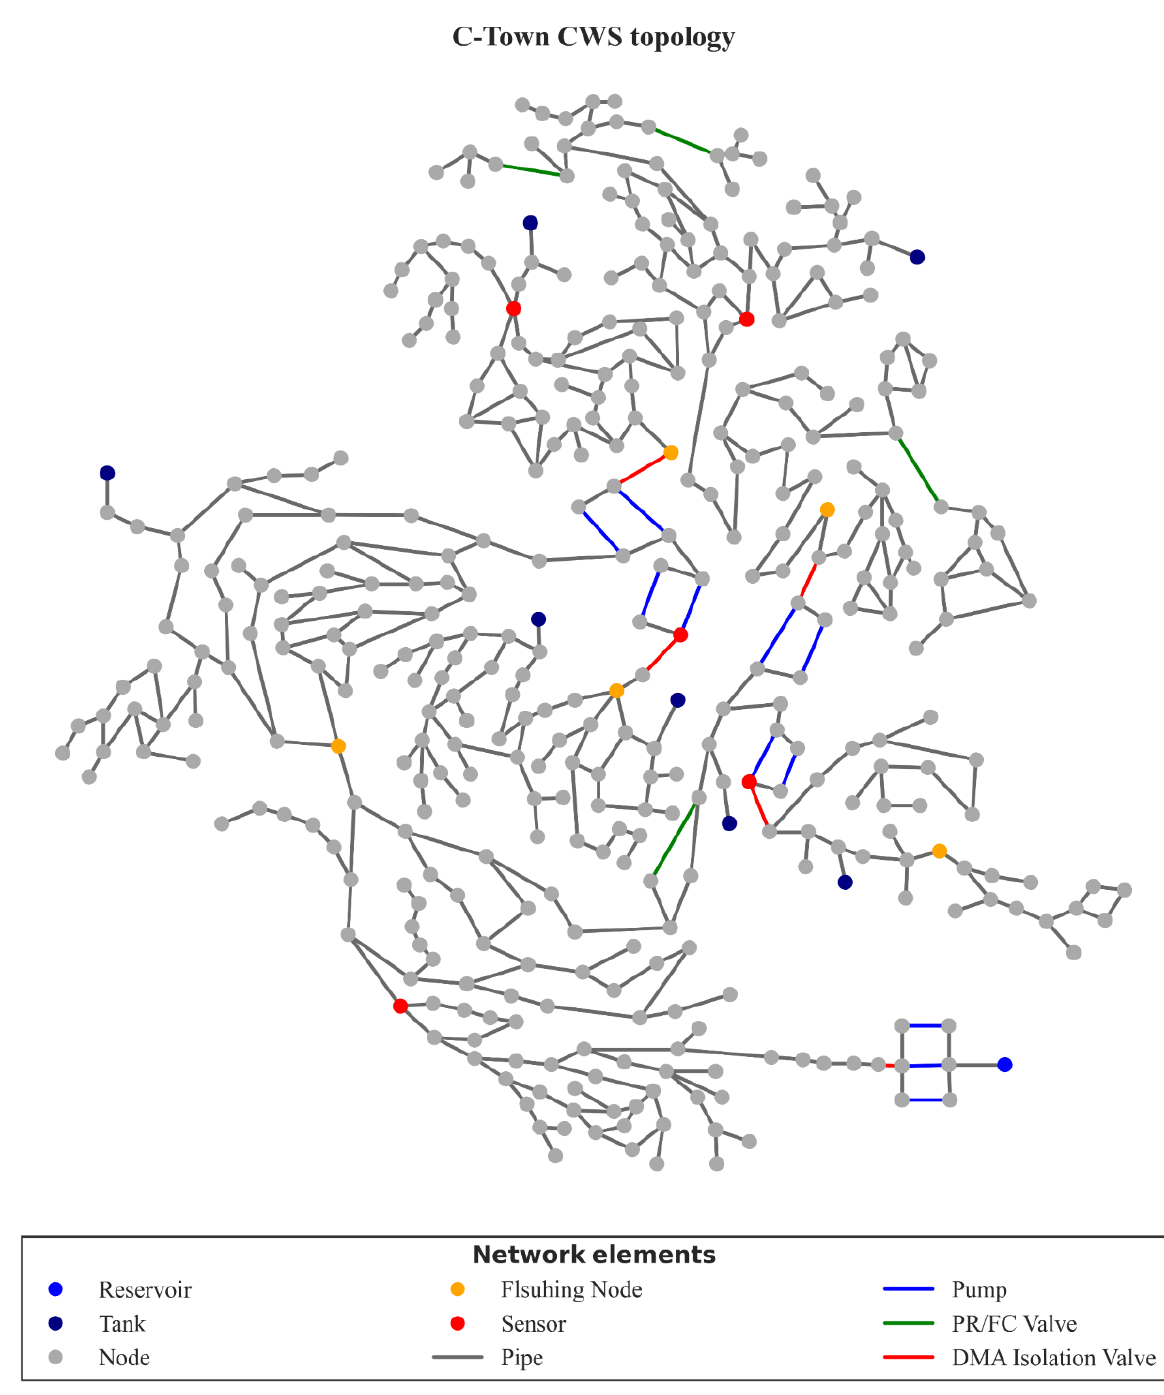
Figure 2. Example of CWS topology for C-Town with a sensor design of five sensors.